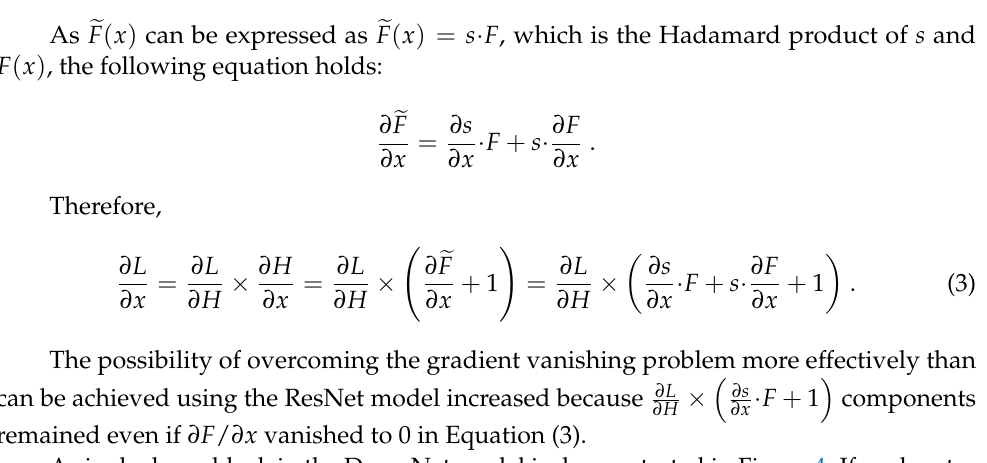
Figure 3. Bottleneck block in the SE-ResNet